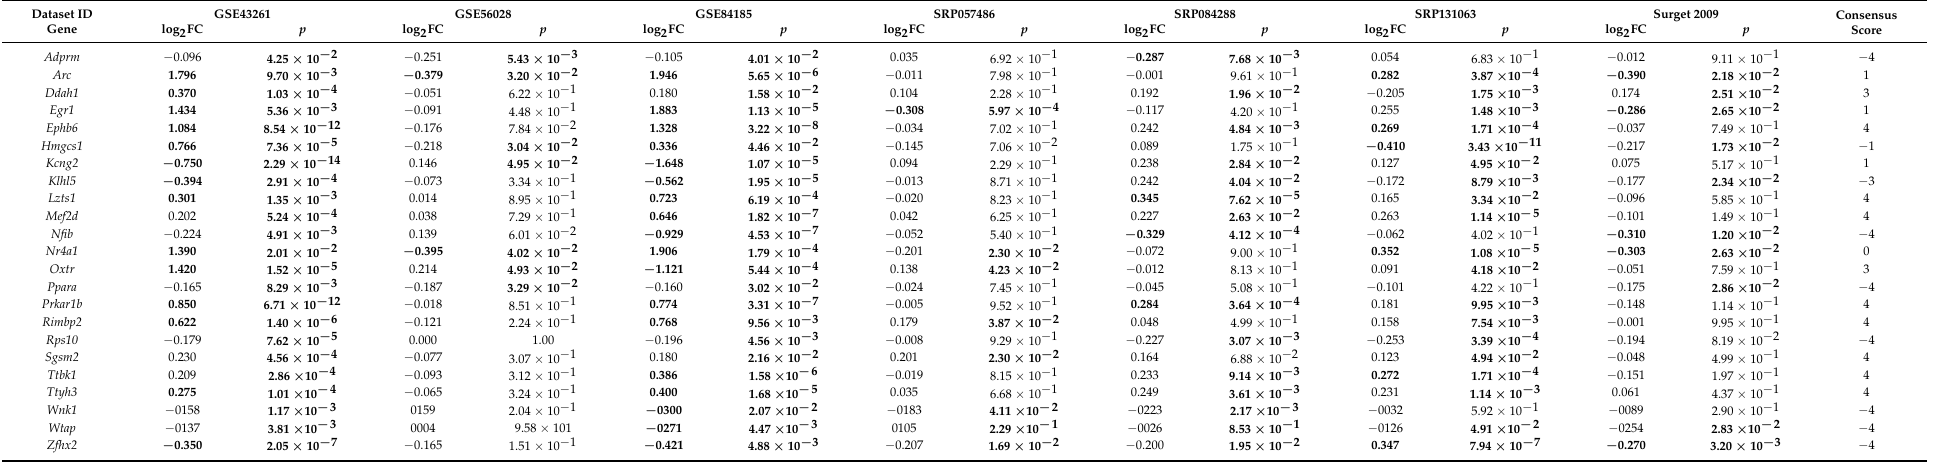
Table 2. Signature of FLX effect in stressed animals (integration method).